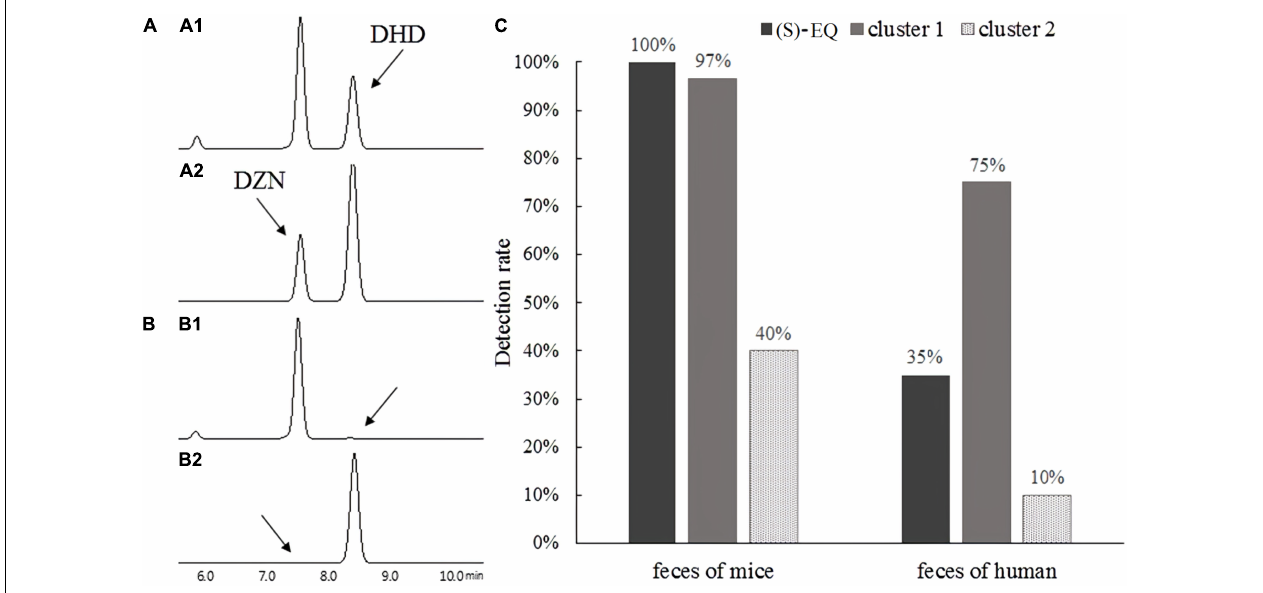
FIGURE 8 | Detection of ( S ) - EQ and K-07020-like genes in human and mice feces. (A1,A2) Denote DZN reductase and DHD oxidase function from 00242_GENOMEO01471_13, showing that the genes in cluster 1 had DZN reductase and DHD oxidase activity. (B1,B2) Denote DZN reductase and DHD oxidase function from GUT_GENOME103990_60 and GUT_GENOME127776_11, however, no DZNRs were found in cluster 3. (C) Detection rate of ( S ) - EQ (HPLC) and K-07020-like genes (PCR) in human and mice